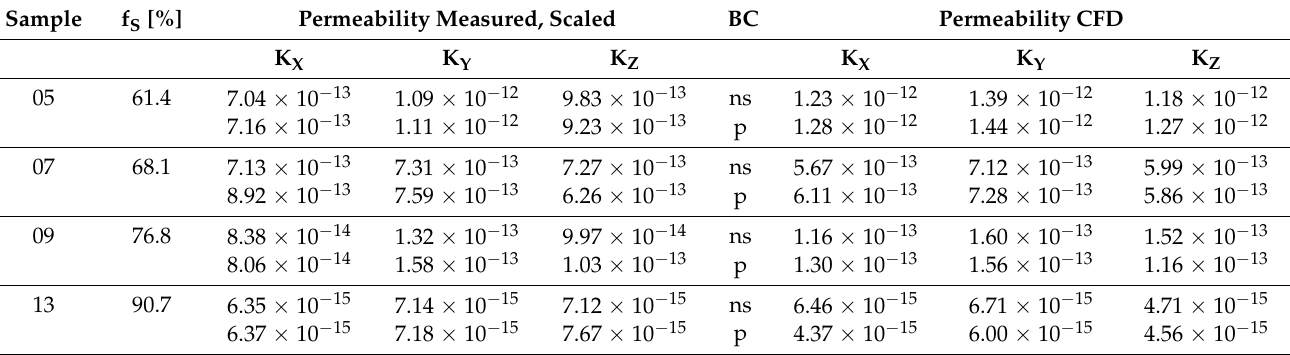
Table 2. Permeability results [m 2